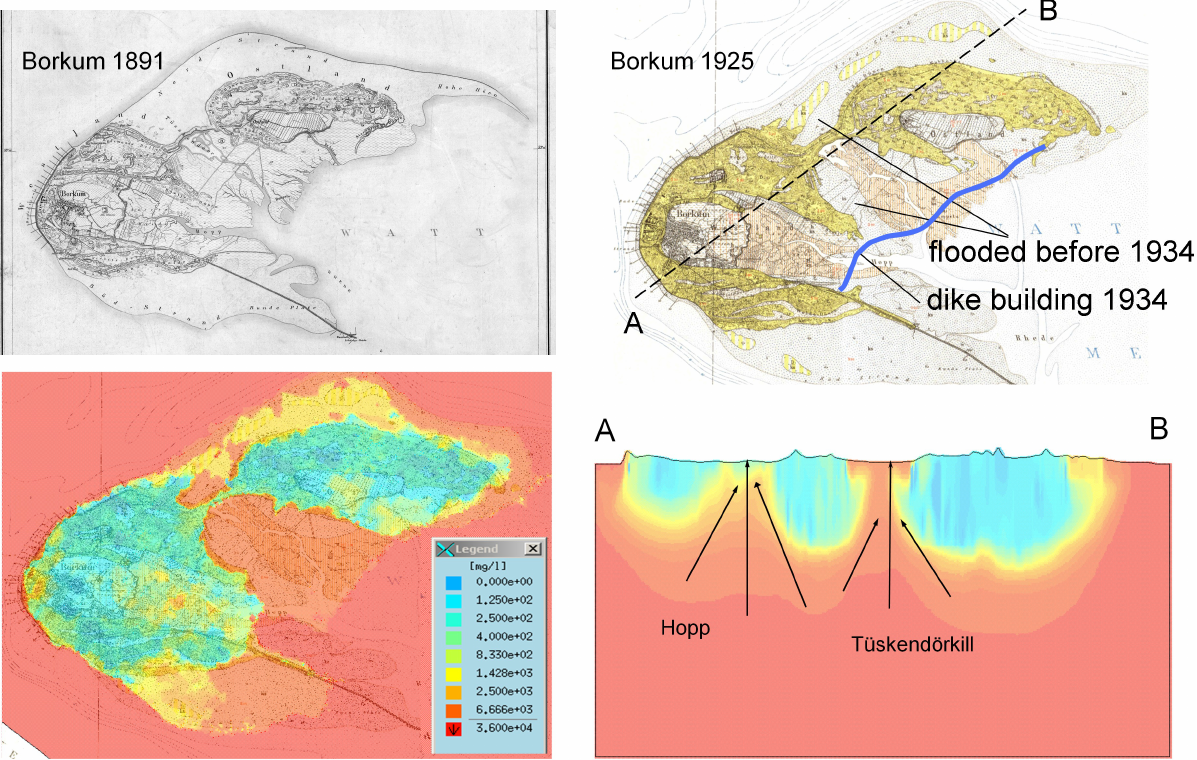
Fig. 12. Inclusion of important factors of hydrological milestones of Borkum into the density calibration by construction of a historical model. Top left and right panels: topographic maps of Borkum 1891 and 1925, bottom panel: historical model of Borkum for the time before the construction of the great south dike (1934), (bottom left panel) TDS distribution at the surface of the groundwater table, bottom right panel: cross-section with TDS distribution A–B through the historical